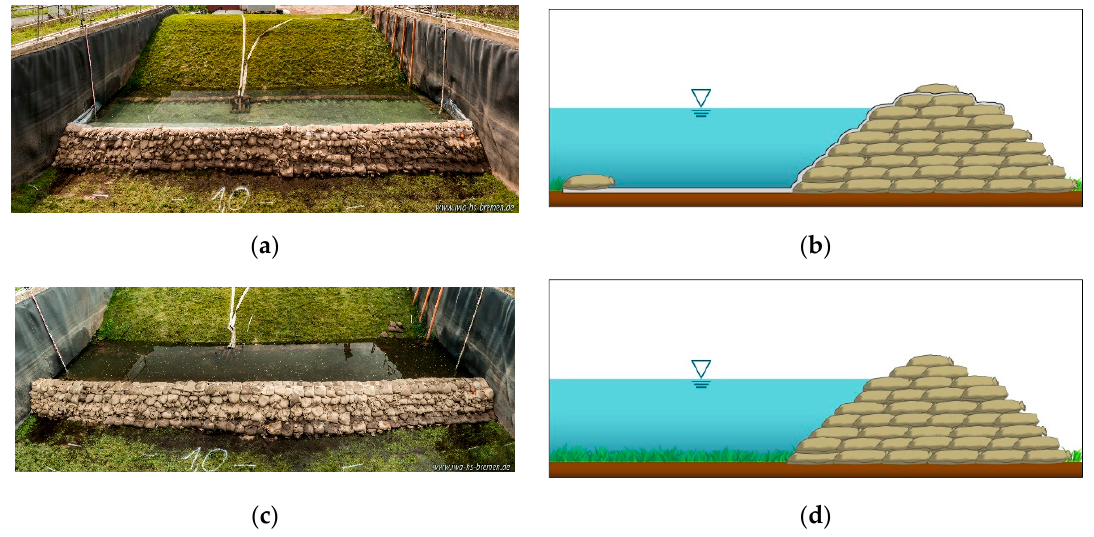
Figure 9. Sandbag flood protection system. ( a ) Sandbag dam with protruding plastic apron ( b ) schematic diagram of the sandbag dam with protruding plastic apron, ( c ) Sandbag dam without protruding plastic apron, and ( d ) schematic diagram of the sandbag dam without protruding plastic apron tested in the IWA facility.